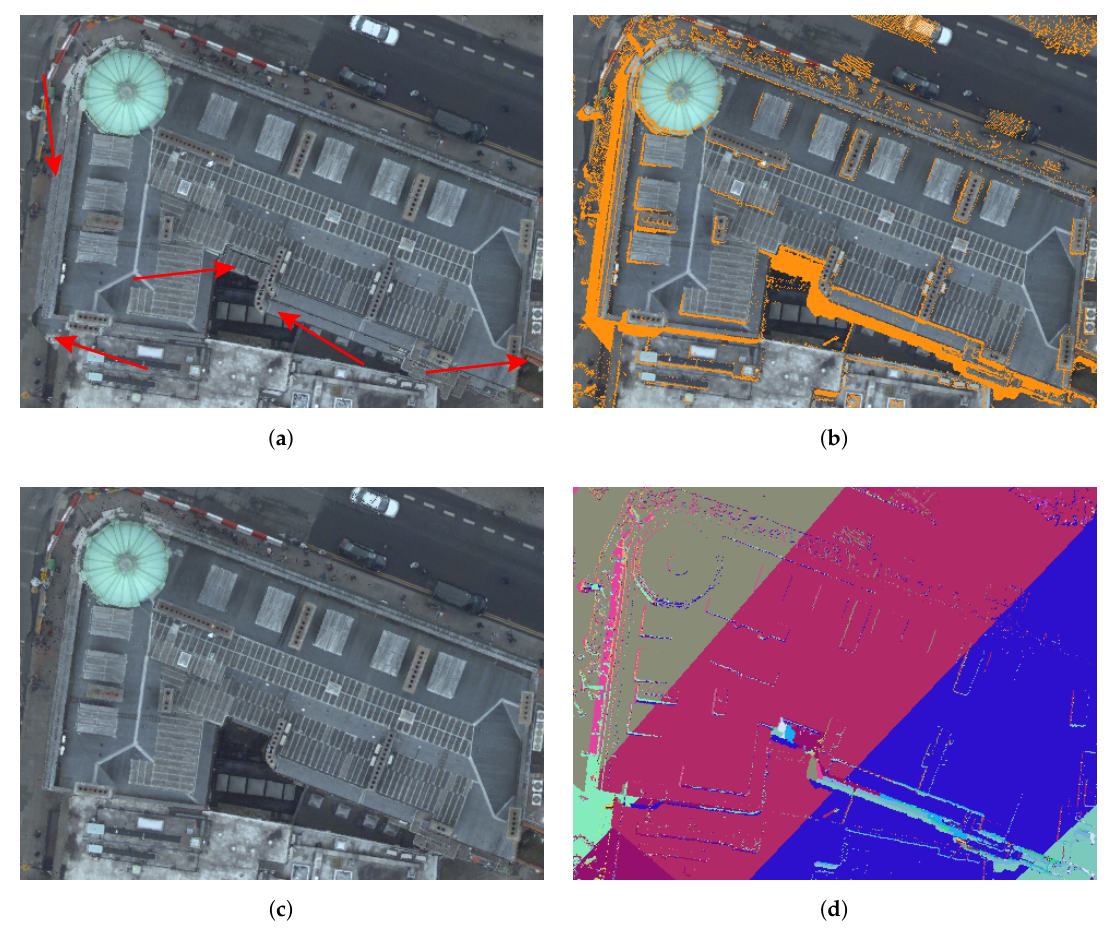
Figure 19. ( a ) Differentially-rectified orthophoto, ( b ) True orthophoto with occluded areas shown in orange, ( c ) True orthophoto generated using the closest visible image criteria, and ( d ) Contribution of images to the true orthophoto shown in part (c). Pixel size is equal to 10 cm in all